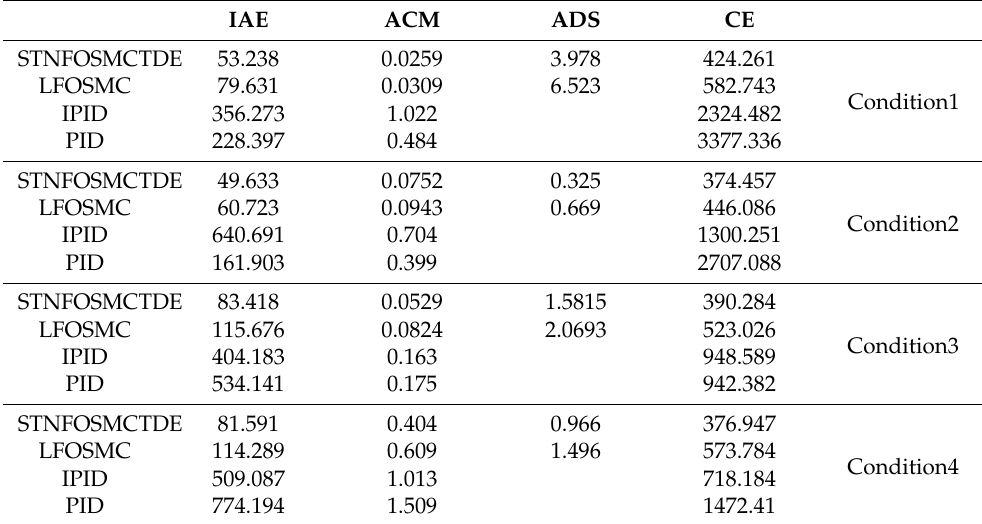
Table 6. Numerical indicators for STNFOSMCTDE, LFOSMC, IPID, and